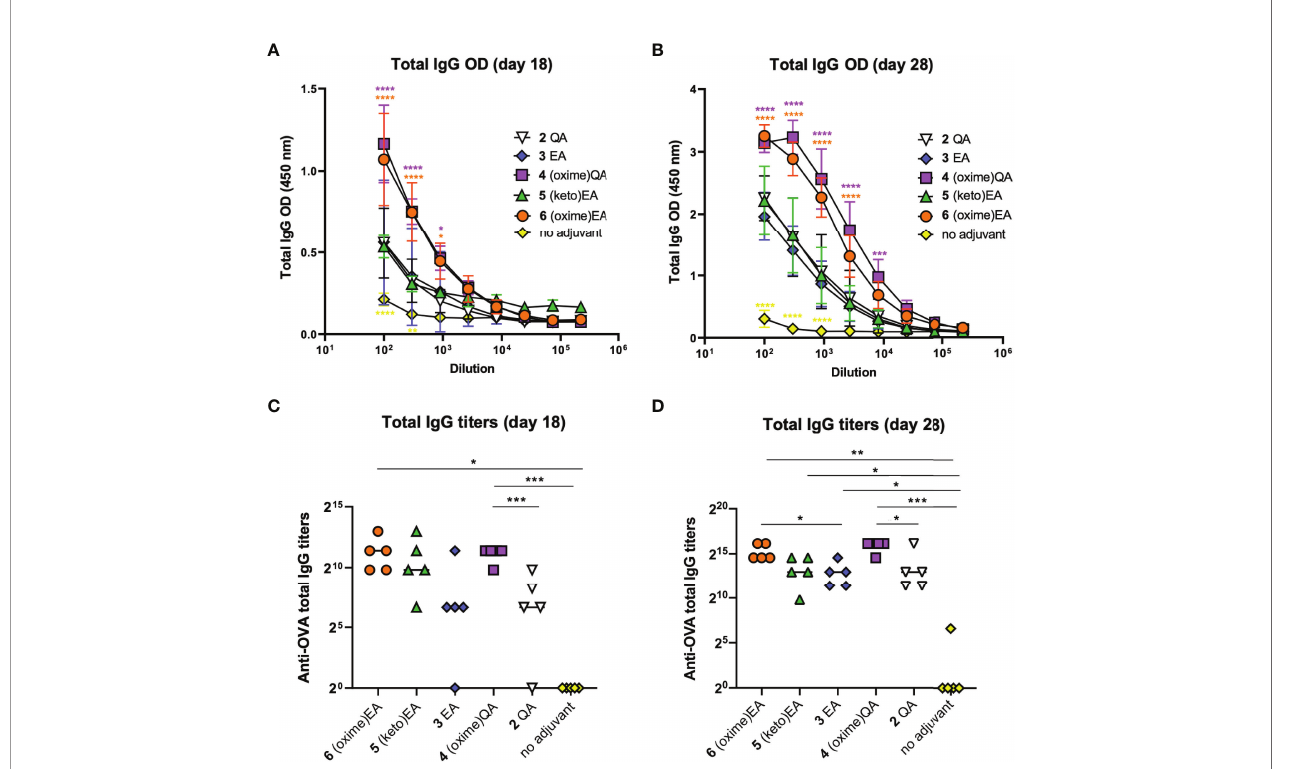
FIGURE 3 | Antibody responses in mice induced by previous lead compounds 2 and 3 and novel saponin adjuvants 4 – 6 coadministered with OVA antigen. (A, B) ELISA standard curves showing total anti-OVA IgG levels (represented as optical density [OD] measurements) in mouse sera on (A) day 18 and (B) day 28 after fi rst immunization. Sera were measured using 3-fold serial dilutions starting at 1/100 serum dilution. Statistical signi fi cance across the different dose-response curves was assessed by comparing to saponin lead 3 EA group using two-way ANOVA Dunnett ’ s multiple comparisons test at the various dilutions. * p ≤ 0.05, ** p ≤ 0.01, *** p ≤ 0.001, **** p ≤ 0.0001. (C, D) Anti-OVA total IgG titers on (C) day 18 and (D) day 28. Data points correspond to individual mice ( fi ve animals per group) and horizontal bars indicate median titers. Statistical signi fi cance was assessed by (1) comparing each group to the no-adjuvant (OVA alone) control and (2) comparing each new saponin variant to its corresponding parent lead (e.g. 4 versus 2 QA; 5 , 6 versus 3 EA) using a two-tailed unpaired Student ’ s t -test with a 95% con fi dence interval (CI) * p ≤ 0.05, ** p ≤ 0.01, *** p ≤